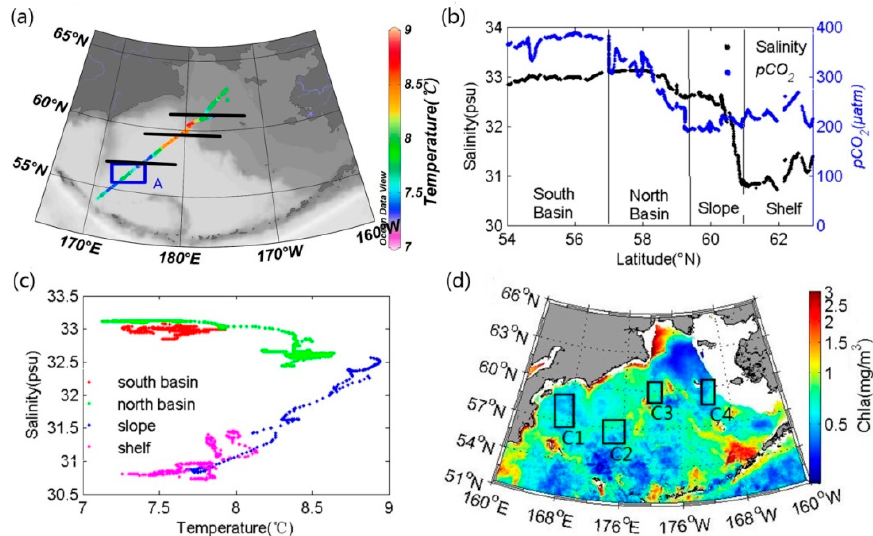
Figure 3. ( a ) Cruise track in July 2010 with temperature marked; ( b ) variation of p CO 2 and salinity with the latitude; ( c ) relationship between temperature and salinity; ( d ) satellite climatology average (2002–2014) chla in July with the coastal areas shallower than 50 m depth masked. The three black lines in ( a , b ) divide the Bering Sea into four sub-regions according to latitude; Box A in ( a ) is the area of reference water mass (55.7–57°N, 171.4–174.2°E); the boxes of C1, C2, C3, and C4 in ( d ) are the typical area in the Kamchatka basin, the eastern basin, slope, and shelf, which are used in the discussion of Section 4.2.